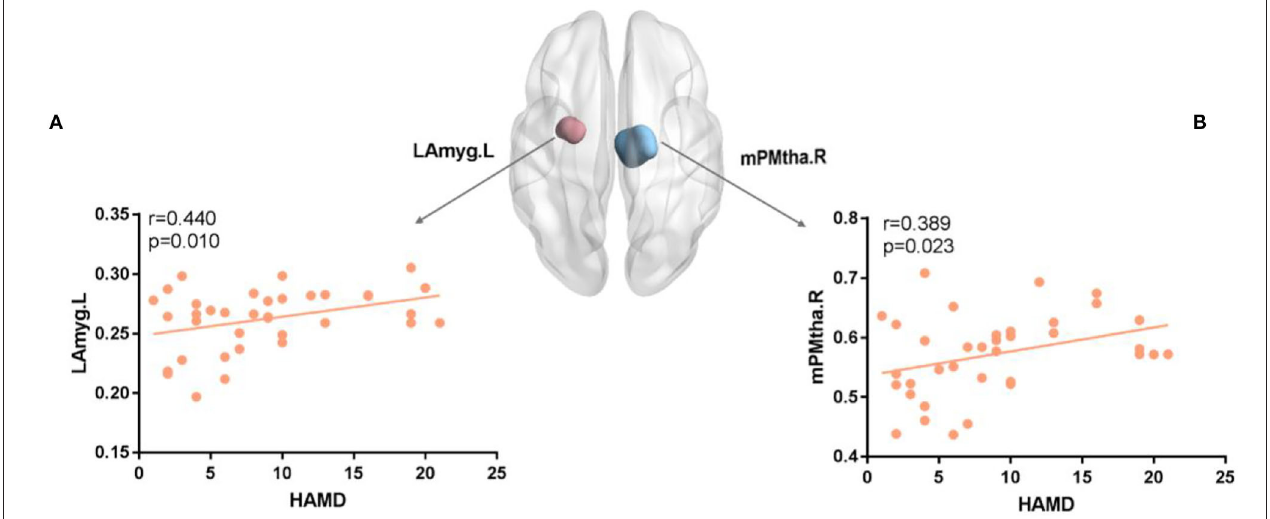
FIGURE 5 | (A,B) The nodal efficiency of several regions was positively correlated with the HAMD score for FN and SN. The brain map showed regions with decreased E nod (Blue for mPMtha.R and pink for LAmyg.L). mPFtha, medial prefrontal thalamus; LAmyg, lateral amygdala; L, left; R,